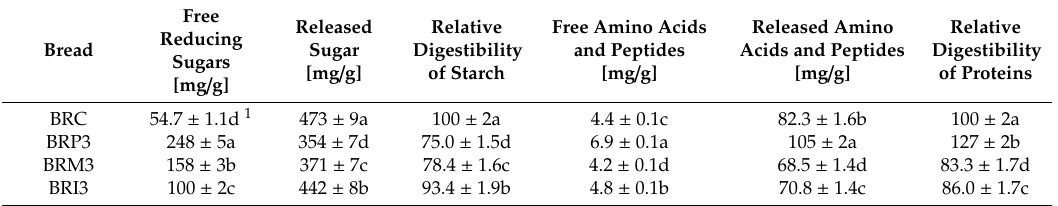
Table 7. Relative digestibility of starch and